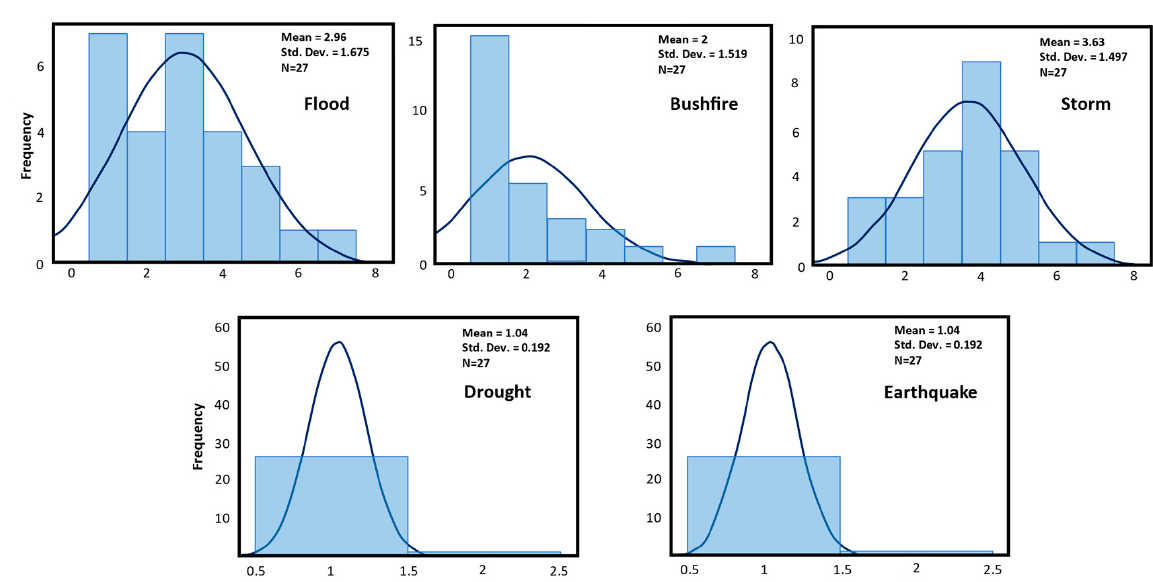
Figure 4. Frequency of floods, bushfires, storms, drought, and earthquakes observed by the respondents.